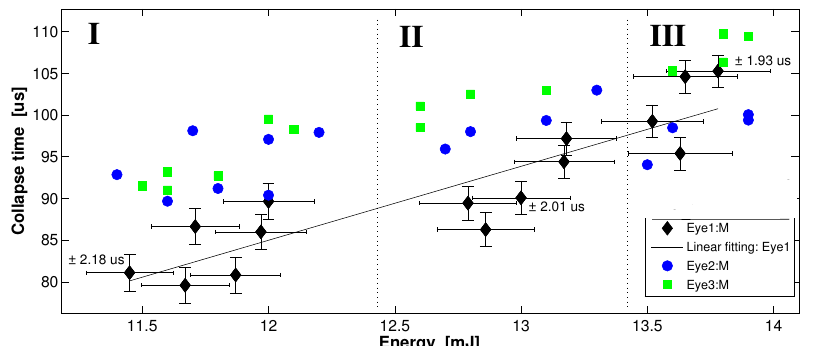
Figure 4. Collapse time dependence on a set of three values of energy per pulse: 12, 13, and 13.9 mJ. Zones I, II, and III represent pulse-to-pulse energy fluctuations. The error bars for data represented by the circles and squares are the same as those related to the diamonds; however, to improve the display clarity of the plot, they were omitted. Each data point represents one shot of the pump beam and its corresponding cavitation bubble collapse